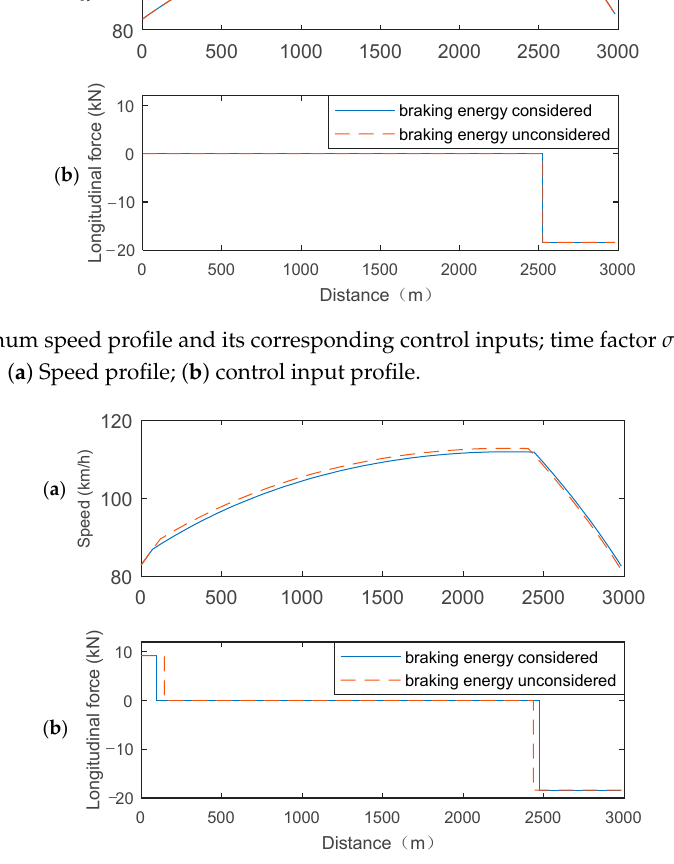
Figure 10. Optimum speed profile and its corresponding control inputs; time factor σ = 40, duration t f = 105 s/104 s. ( a ) Speed profile; ( b ) control input profile. Table 4. The quantitative analysis of the simulated results. RFC: real fuel consumption. Units Convex Concave